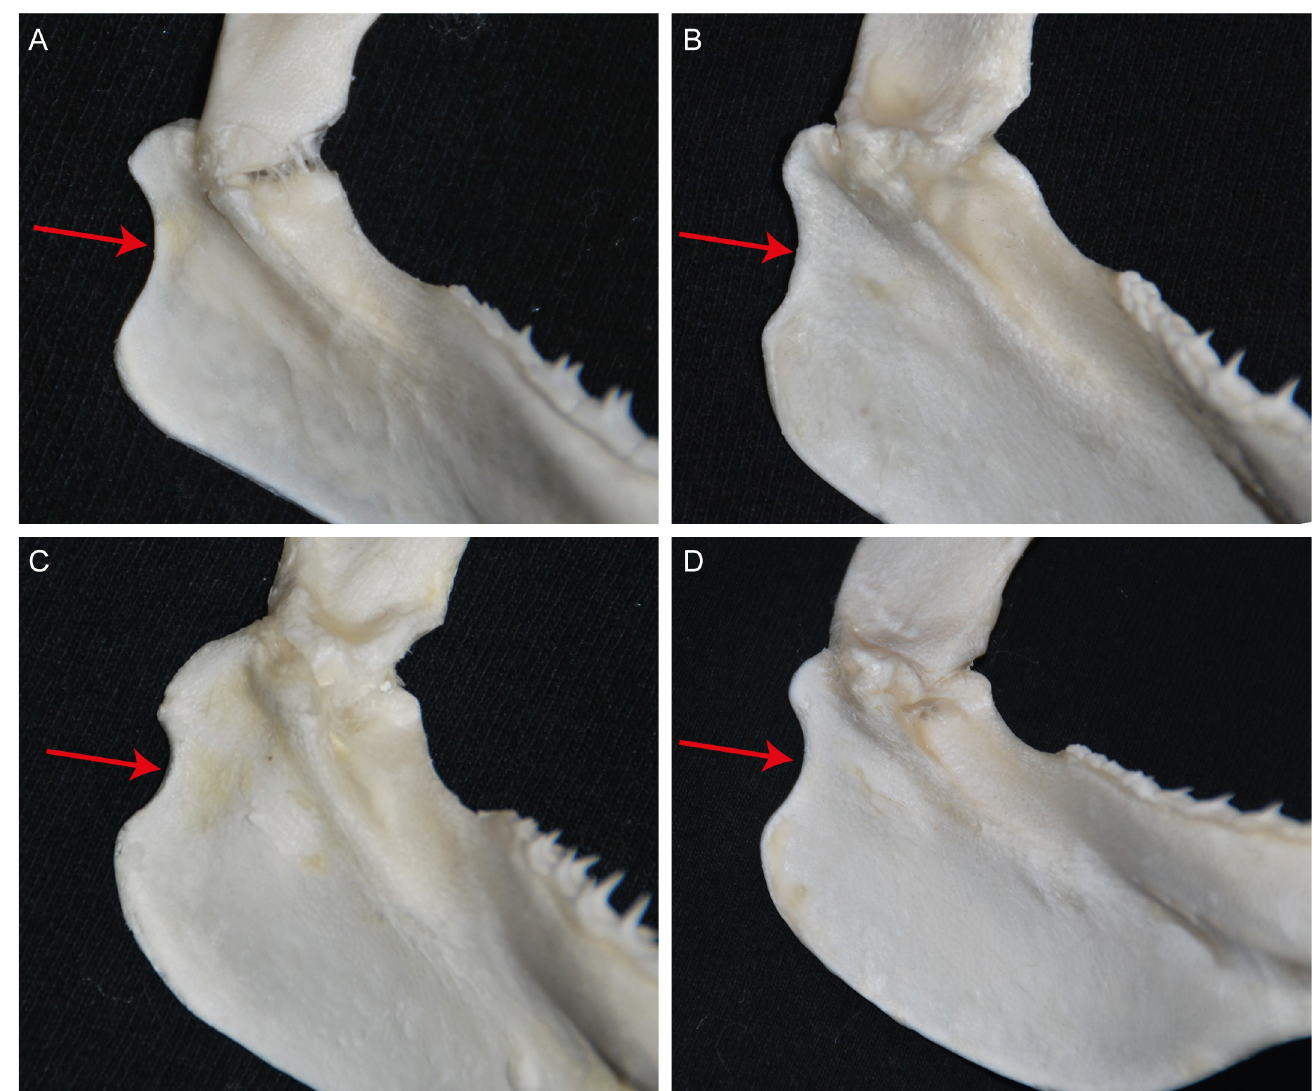
Fig 11. Post-mandibular indentation of Meckel’s cartilage. Arrow denotes indentation: A. Carcharhinus borneensis (PMH 244–1, female 661mm TL); B. Carcharhinus cerdale (PMH 329–01, male 887 mm TL); C. Carcharhinus macloti (PMH 057–14, male 970 mm TL; D. Carcharhinus porosus (PMH 121–01, female 1085 mm TL).